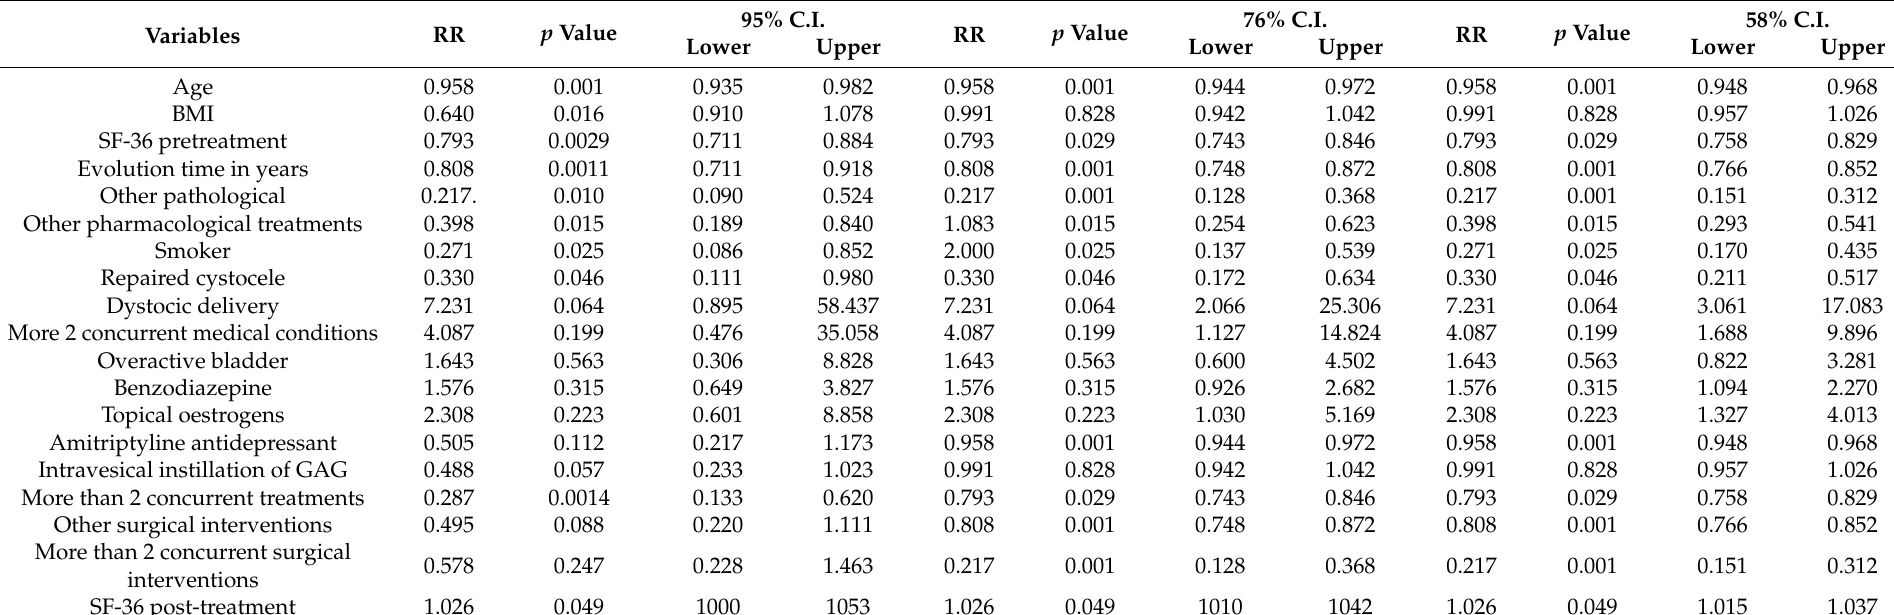
Table 3. Logistic regression analysis of the relative risk of women who have the analyzed variables of being treated with adjuvant